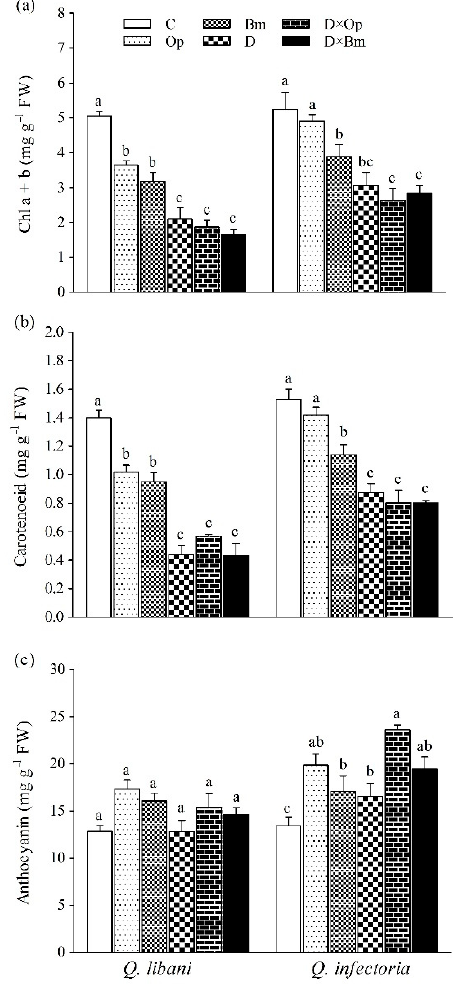
Figure 6. ( a ) Chlorophyll a + b, ( b ) carotenoid, and ( c ) and anthocyanin content in leaves of Quercus libani and Q. infectoria seedlings affected by charcoal disease, drought, and their combined effects. Op: Obolarina persica , Bm: Biscogniauxia mediterranea , D: Drought, D × Op: Drought × O. persica and D × Bm: Drought × B. mediterranea . Bars represent means + standard error, n = 3. Different lower-case letters indicate statistically significant differences between the treatments at α = 0.05 based on Tukey’s multiple comparison